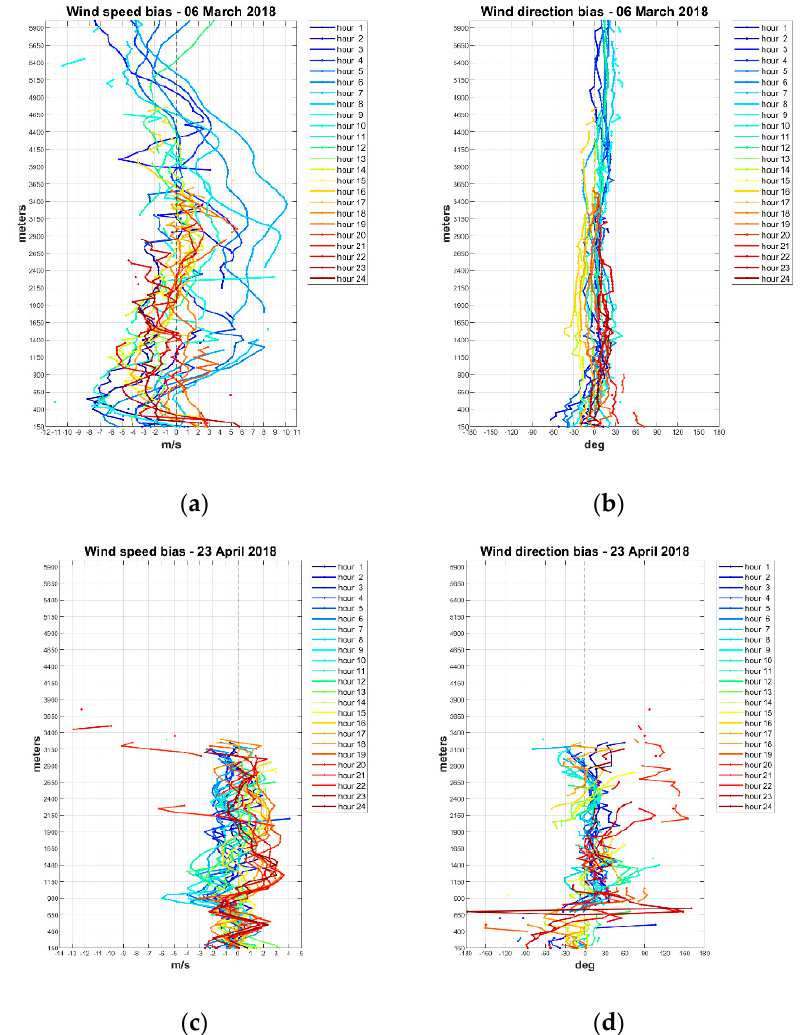
Figure 9. Vertical profiles of speed ( a , c ) and direction ( b , d ) bias for each hour on 6 March 2018 ( a , b ) and 23 April 2018 ( c , d ).